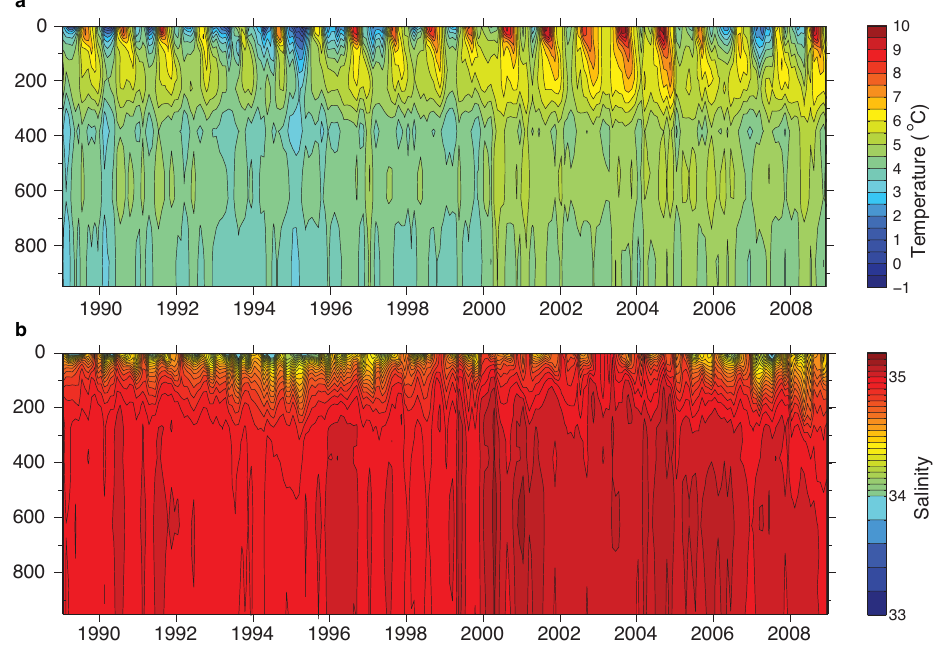
Fig. 5. Hovmøller diagrams showing potential temperature (a) and salinity (b) in ocean reanalysis. The data area-averaged across black box shown in Fig.